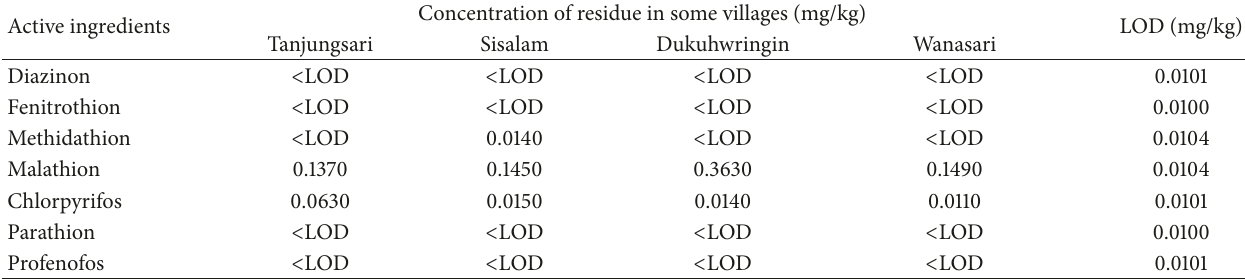
Table 3: Pesticides residue found in soil samples from agricultural land in some of Wanasari’s village (organophosphate group). Active